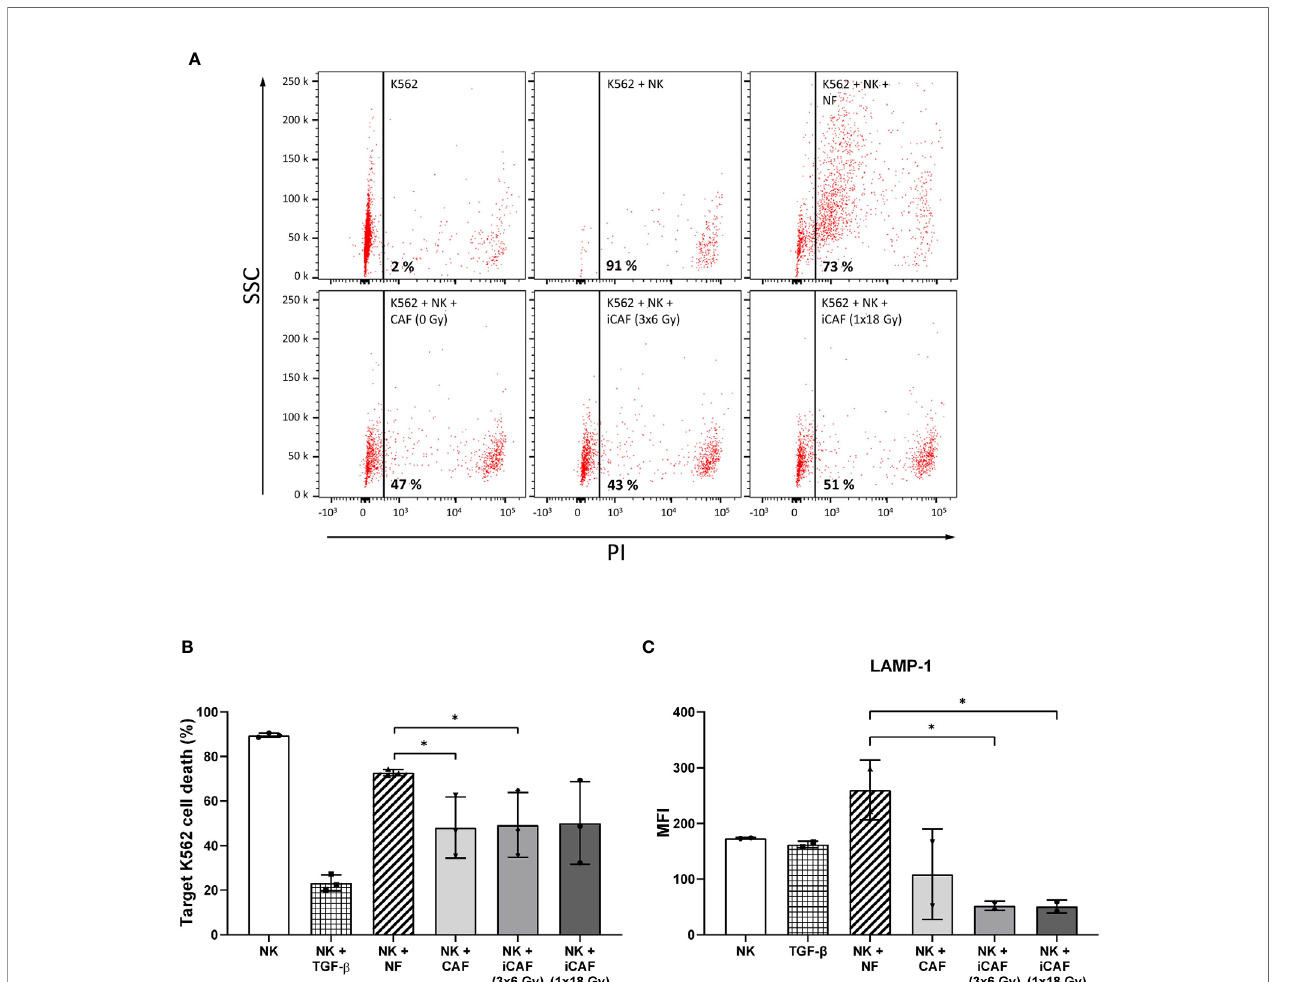
FIGURE 4 | Effects of cancer-associated fi broblasts (CAFs) on natural killer (NK) cell cytotoxic activity. Cytotoxic activity of NK cells co-cultured with fi broblasts was analyzed against CSFE-labeled K562 leukemic tumor cells at NK to target ratio of 5:1. Results were evaluated by fl ow cytometry and presented as percentage propidium-iodide positive (dead) cells versus side scatter activity (SSC). TGF- b treated NK cells served as control for repressed cytotoxic activity. Panels in (A) represent fl ow cytometry dot-plots from a representative experiment with one of the CAF donors. In (B) , NK cell cytotoxic activity is represented as mean (± SD) values from fl ow experiments with three different CAF donors. Statistical P -values between mixed cultures with NF and CAFs were determined using one-way ANOVA with Tukey correction for multiple comparisons. Similarly, in (C) , NK cell degranulation values are calculated as levels of LAMP-1 (CD107a) present on the NK cell surface after being employed against K562 leukemic tumor cells (for 4 h), at a NK to target ratio of 5:1, and an initial co-culturing with CAFs. Data represent mean (± SD) values from three different donors. * indicates P <